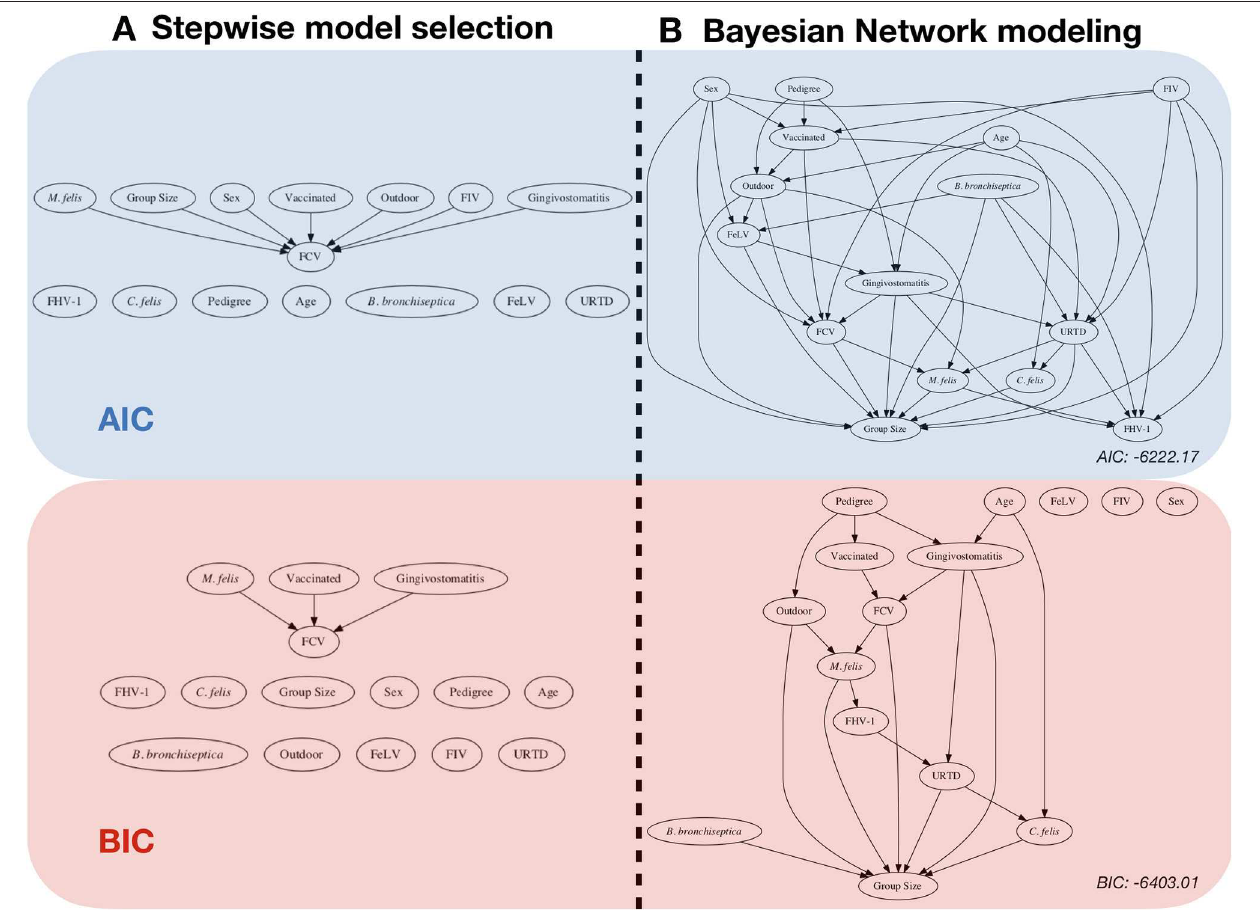
FIGURE 1 | Risk factor analysis with the FCV dataset. Comparison between: (A) classical stepwise multivariable model selection using two different model scores, represented by a network (backward-forward model selection algorithm), and (B) Bayesian network (BN) analysis with two scores and the corresponding network (using an Additive Bayesian Network algorithm). For ease of comparison, we chose to present the classical regression approach in a network format as well. The blue part was performed by using the AIC (Akaike Information criteria) score, and the red part was performed by using the BIC (Bayesian Information Criteria) score. Stepwise model selection and BN modeling using the same score gives very similar results. The BN models depict a more detailed description of the data. The objective of this paper is to describe how to obtain and to interpret such a